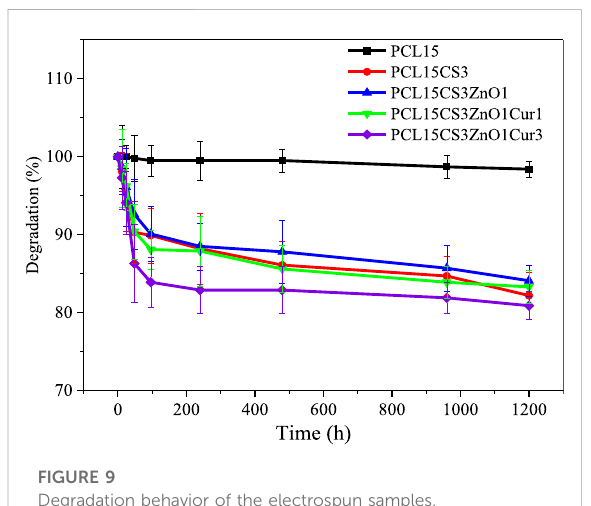
FIGURE 10 Release pro fi le with their fi tted Peppas model of the Cur- containing electrospun